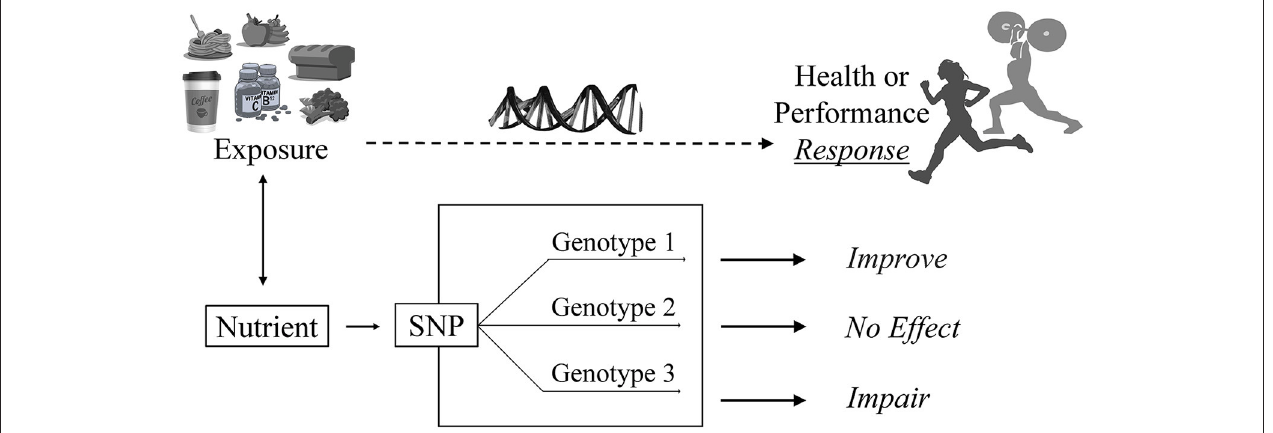
FIGURE 1 | The nutrigenomics approach to sport nutrition. An athlete is exposed to a food, beverage, nutrient or bioactive. A genetic variant such as a single nucleotide polymorphism (SNP) associated with that exposure modifiers the individual’s requirement for or response to that exposure. Their unique response depends on their version of the gene or “genotype.” For example, in the CYP1A2 rs726551 SNP, individuals with the AA genotype (fast metabolizers) experience a positive or “improved” response (i.e., performance) to caffeine. Individuals with the CYP1A2 AC or CC genotype experience no effect or impaired performance, respectively, from caffeine use